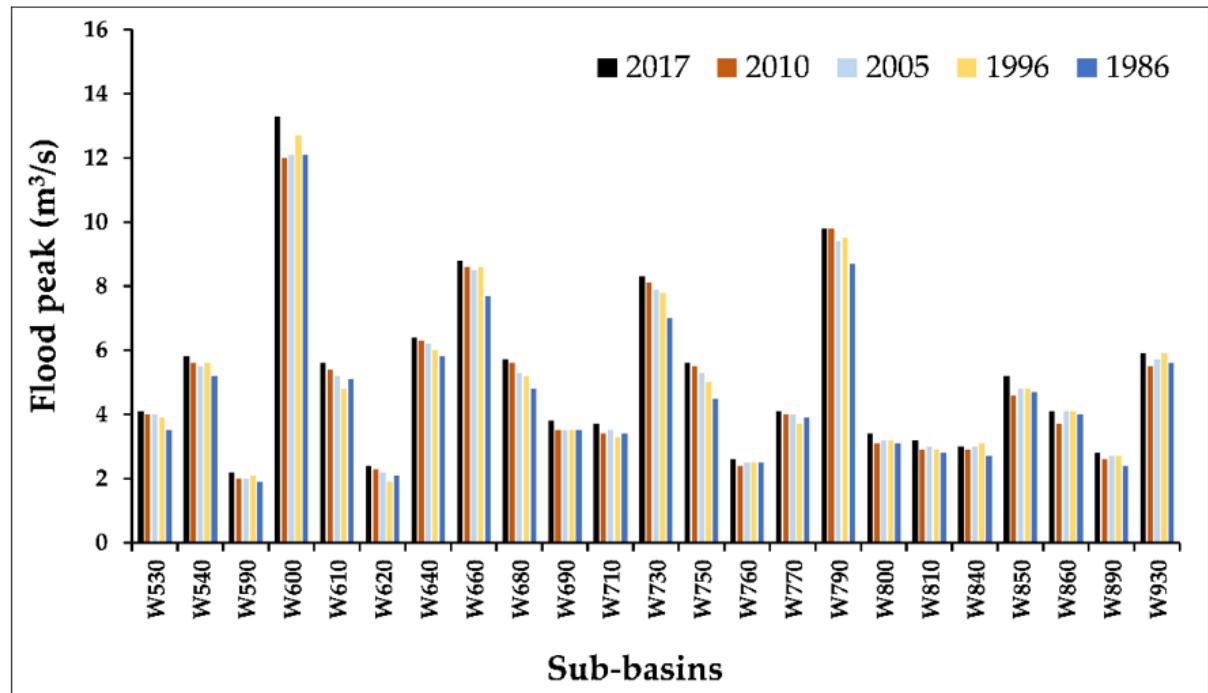
Figure 9. Change in land use/cover area at the sub-basin scale and the corresponding change in flood peak from 1986 to 2017.